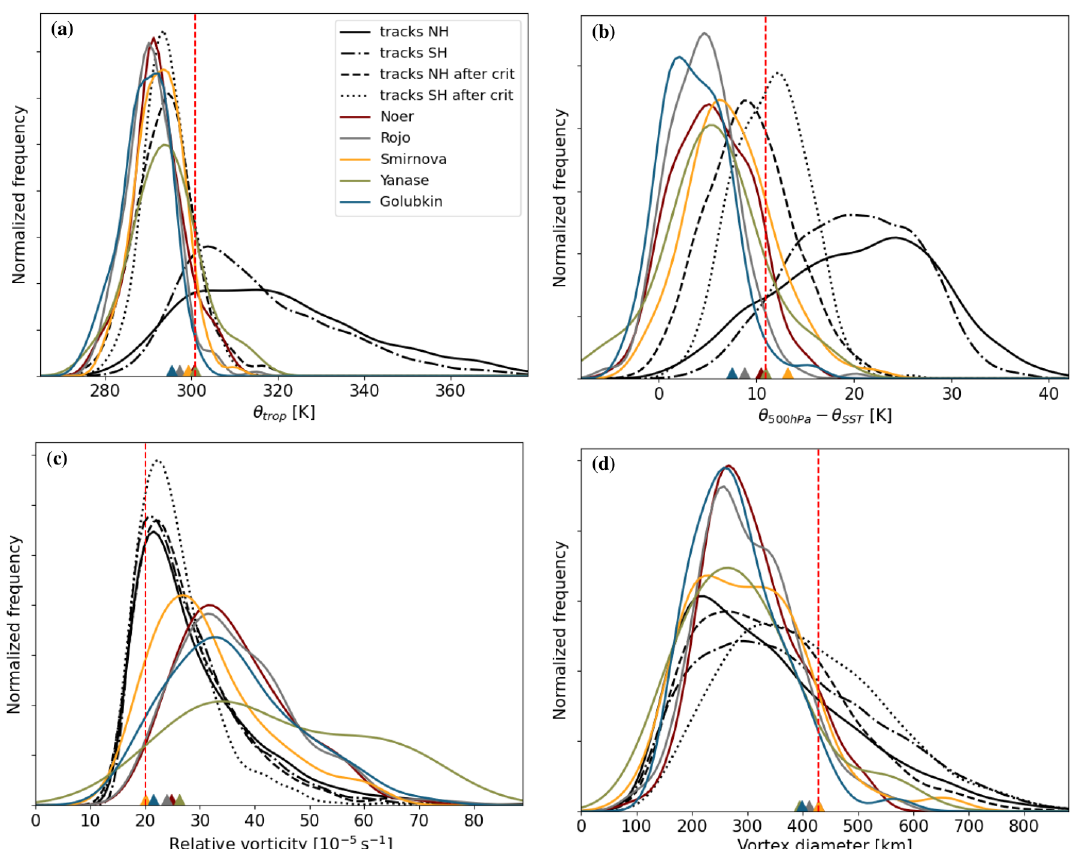
Figure 1. Parameter distributions for polar lows from the different lists (colours) and cyclone tracks of both hemispheres (black). These parameters are successful in distinguishing between polar lows and cyclone tracks, hence becoming the polar-low criteria. The tracks that remain after the application of the other three polar-low criteria are presented (black dashed-dotted and dotted) to express the additional value of the parameter to the other three criteria. (a) The potential temperature at the tropopause, θ trop , is computed as the lifetime mean of the track, and (b) the potential static stability, θ 500hPa − θ SST , is calculated as the lifetime minimum. (c) The relative vorticity and (d) the vortex diameter express the lifetime maximum. The coloured triangle along the x axis denotes the threshold satisfied by 90% of the polar lows of each list. The vertical red dashed lines denote the thresholds of the polar-low criteria. NH: Northern Hemisphere, SH: Southern Hemisphere, crit: